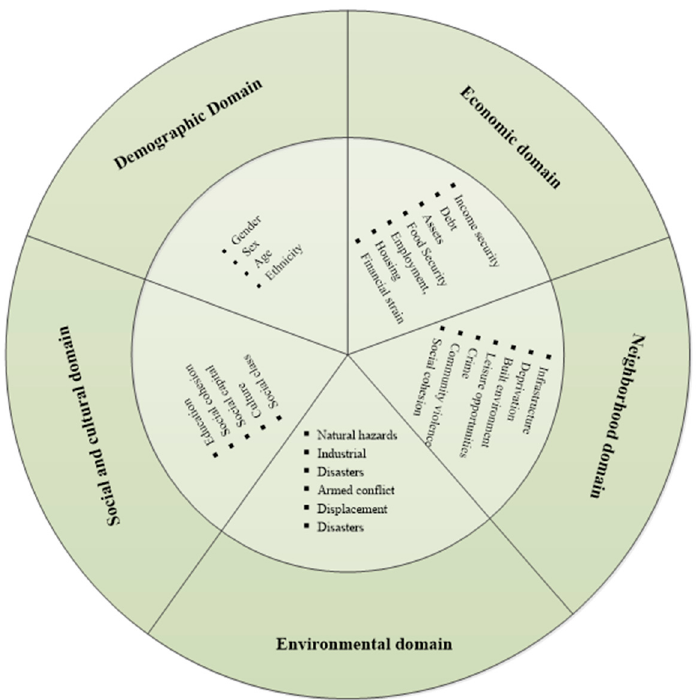
Figure 1. Conceptual framework for multiple social determinants domains of mental disorders.